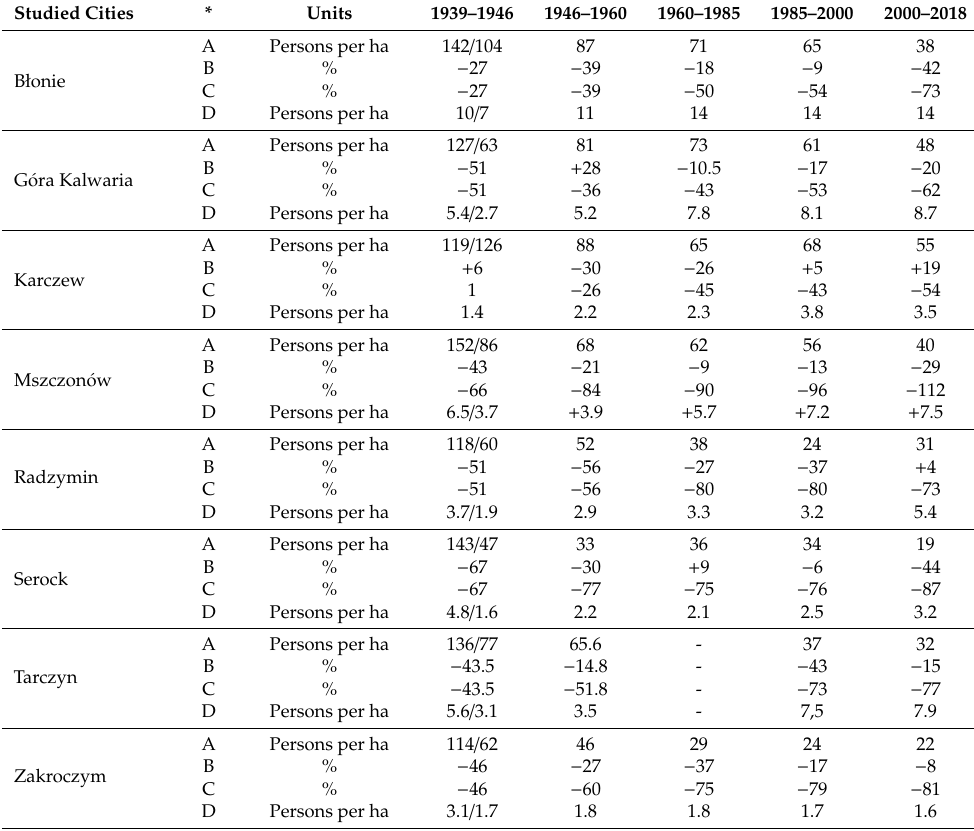
Table 3. Changes in population density in the studied cities in the years 1939–2018 (for Tarczyn, the analysis concerned the years 2002–2018).